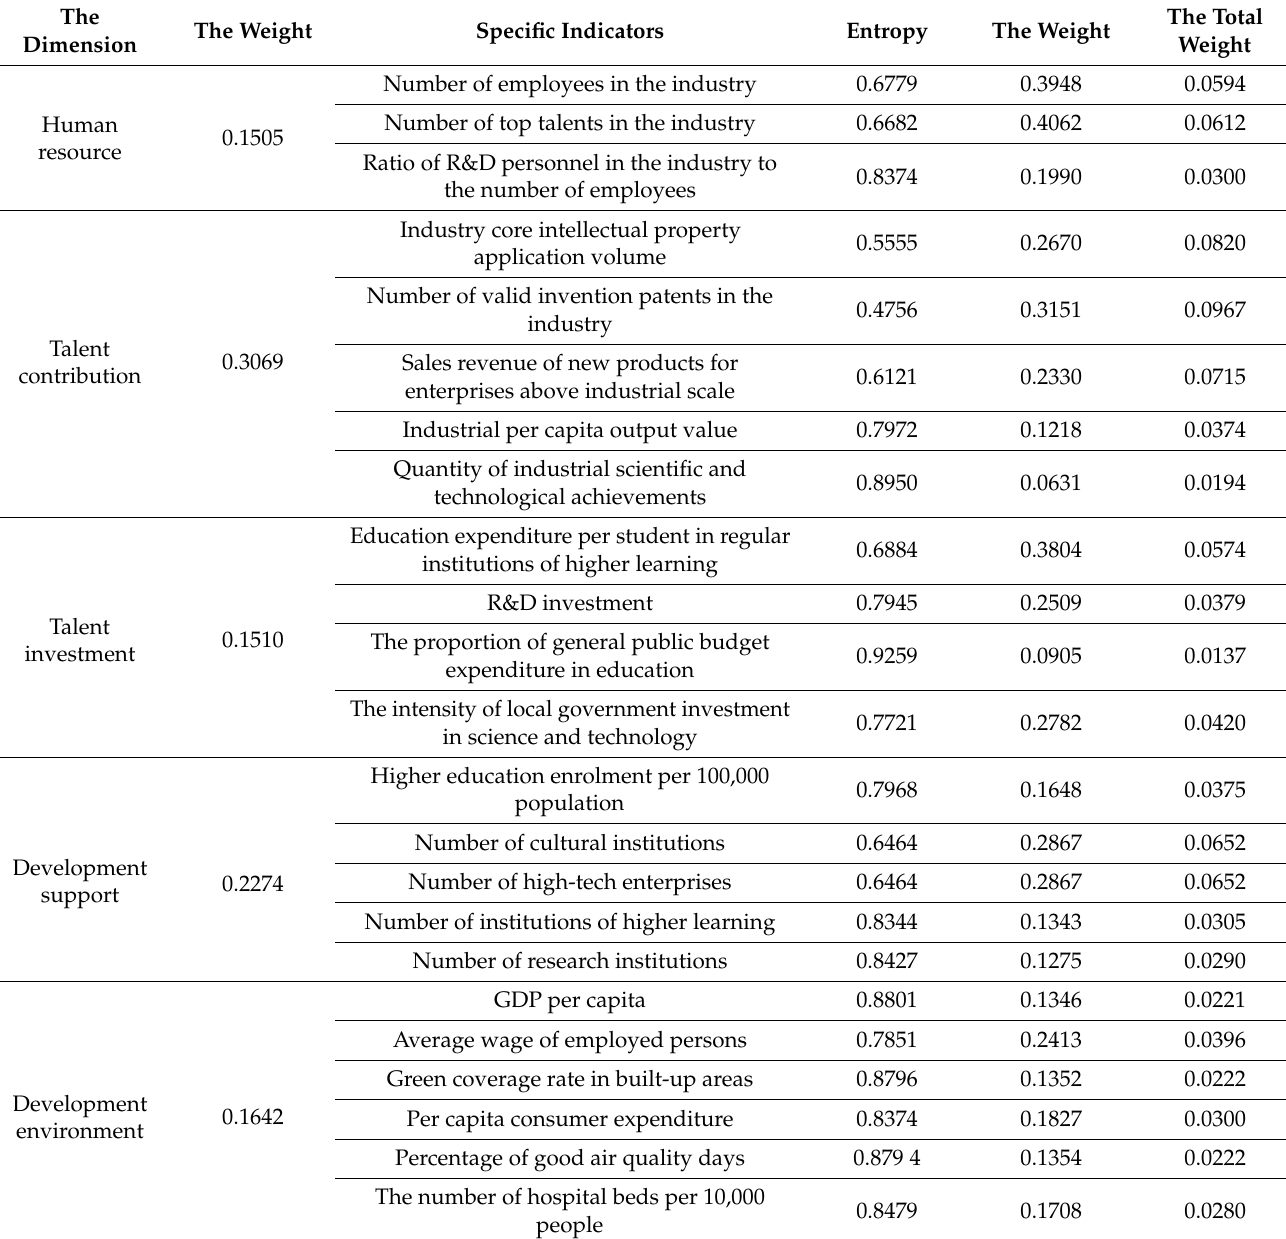
Table 4. Talent competitiveness evaluation index weight of the intelligent